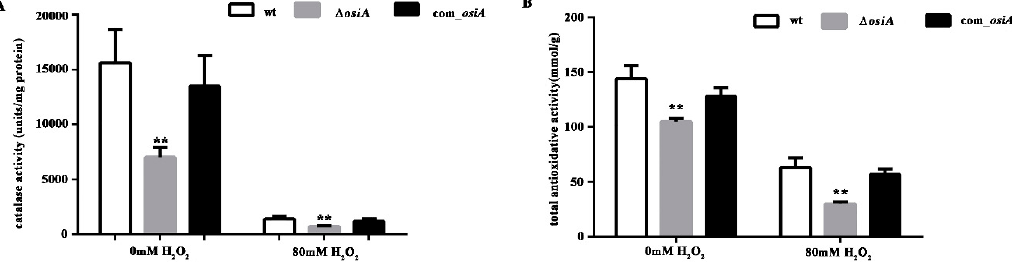
Figure 2. Catalase activity and total antioxidative activity of the wild type strain and osiA mutant strain. ( A ) Catalase activity of the wt, ∆ osiA , and osiA complementary strain. ( B ) Total antioxidative activity of the wt, ∆ osiA , and osiA complementary strain. ** means the difference is very significant compared with the control group, that is, the p value is less than 0.01.